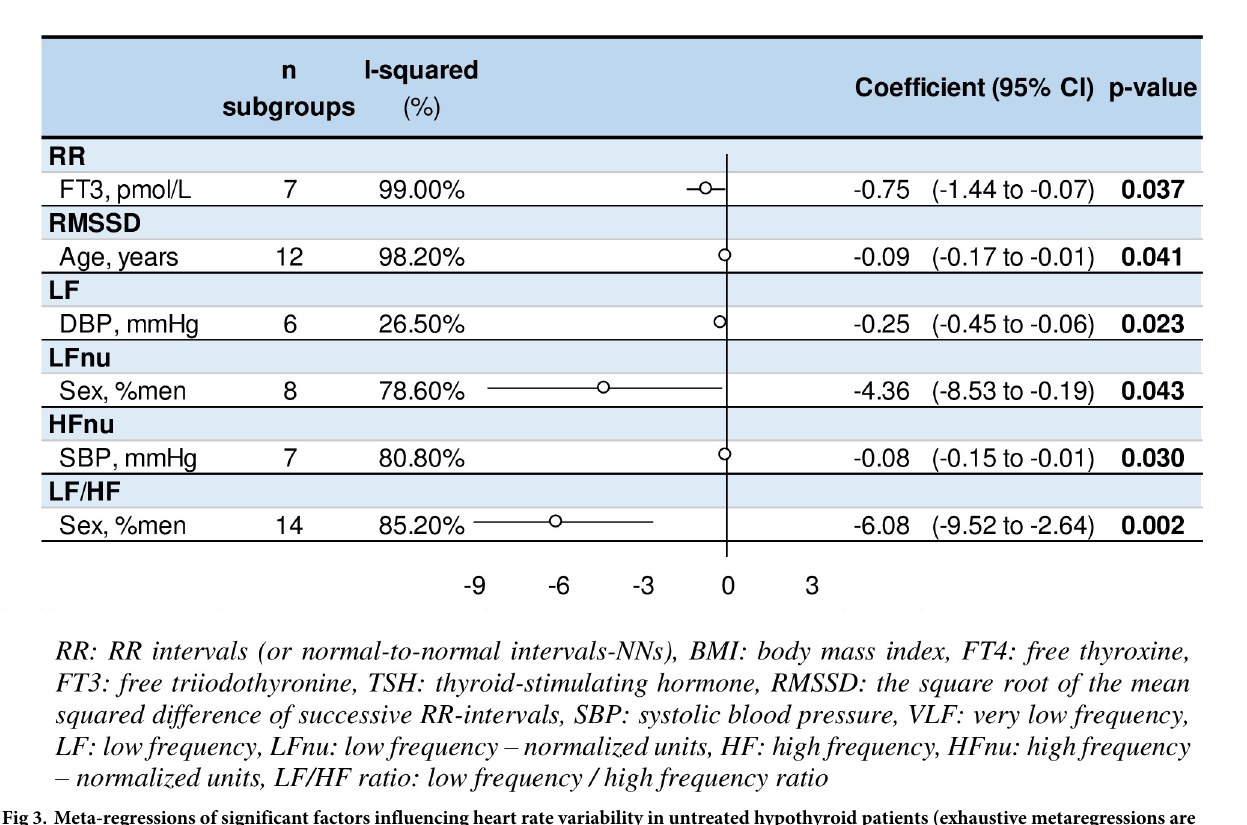
Fig 3. Meta-regressions of significant factors influencing heart rate variability in untreated hypothyroid patients (exhaustive metaregressions are presented in S5 Fig).